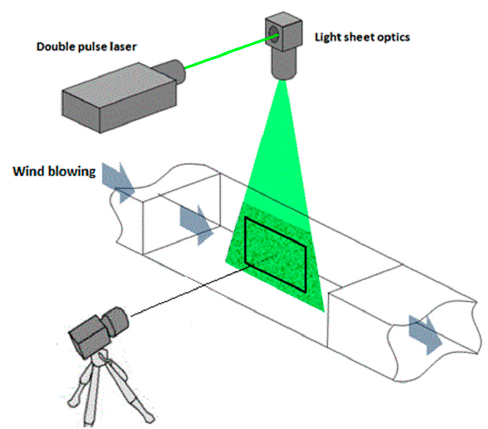
Figure 5. Vertical measurement plane (2D) applied in all the experiments conducted with the Particle Image Velocimetry (PIV) technique.